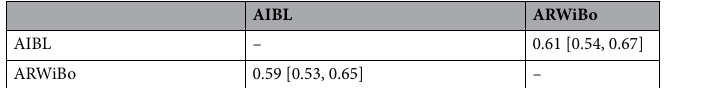
Table 4. Generalization performance of the classifiers for the classification between HC and patients with mild cognitive impairment. In this table, the rows indicate the dataset where the classifier is trained and the columns indicate the dataset where the performance was measured. The area under the receiver operating characteristic curve is shown with the upper and lower bound of its 95% confidence interval. No case had a performance significantly different from the normative approach calculated using the confidence interval of the difference between the approach across the bootstrap scheme.